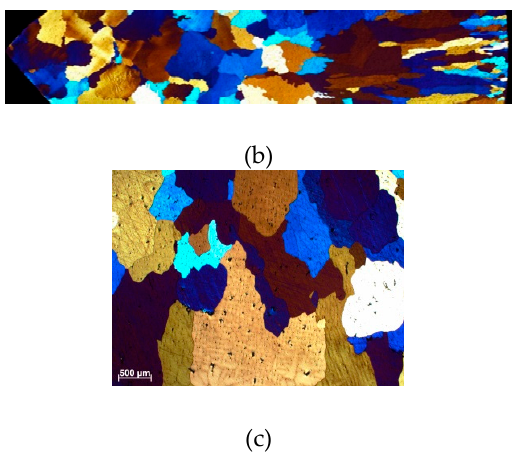
Figure 2. Macro ( a ) and micro ( b , c ) grain structure of a reference sample cast at 670 °C in a TP1 mould. The positions of photos in ( b ) and ( c ) with respect to the sample cross-section are marked in ( a ) (same positions have been used hereafter).